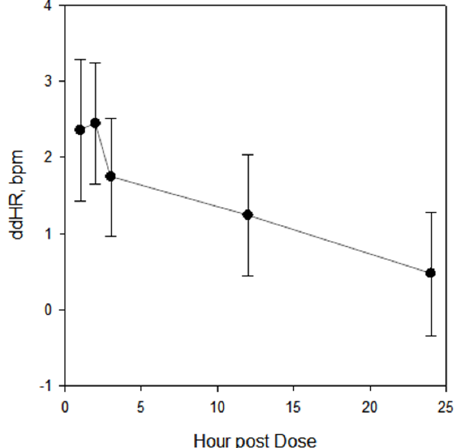
Figure 1. Mean ddHR and 95% CI, all seven studies combined. An HR increase was present and maximal at 2 h after administration of moxifloxacin. HR then decreased during the ensuing 22 h. The lower 95% confidence interval (CI) exceeded 0 at all but the last time point.